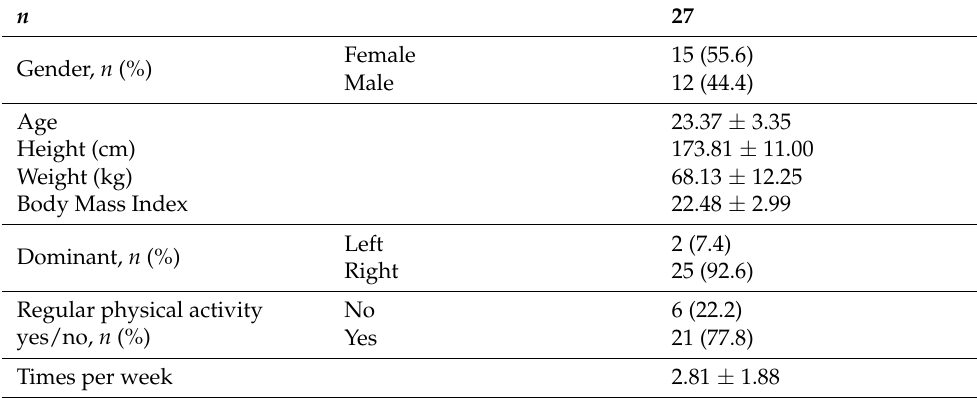
Table 1. Baseline characteristics of participants.